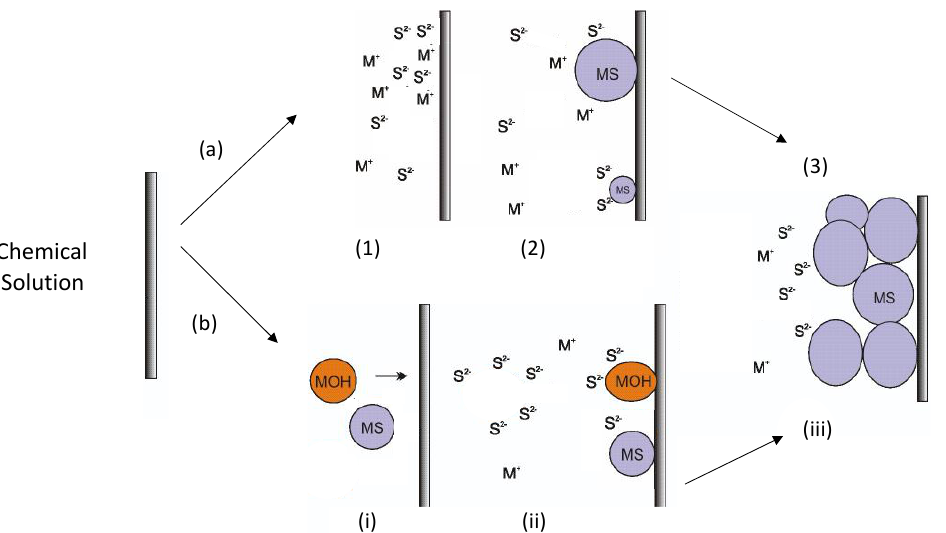
Figure 1. ( a ) Schematic diagram of the ion – ion mechanism: (1) Ion diffusion (M + represents Zn 2+ or In 3+ ) from bulk solution to substrate surface. (2) Heterogeneous nucleation on the substrate surface and crystal growth on substrate surface. (3) Coalescence and growth of films. ( b ) Cluster – cluster mechanism: (i) metal sulfide and metal hydroxide particle formation into bulk solution, followed by solid particle diffusion to substrate surface. (ii) Diffusion of sulfide ions and reaction with solid particles located on the substrate surface and crystal growth by interchange reactions (metal hy- droxide) and by sulfide addition (metal sulfide). (iii) Particle growth occurs both inside the solution and on the substrate surface. Bars represent solid substrates.